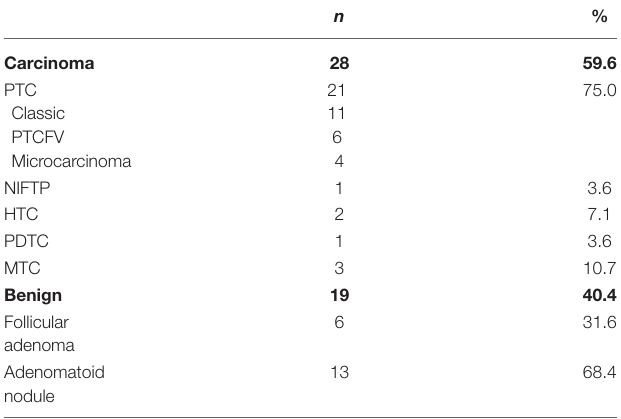
TABLE 2 | Histology of 47 cytologically indeterminate thyroid nodules. n